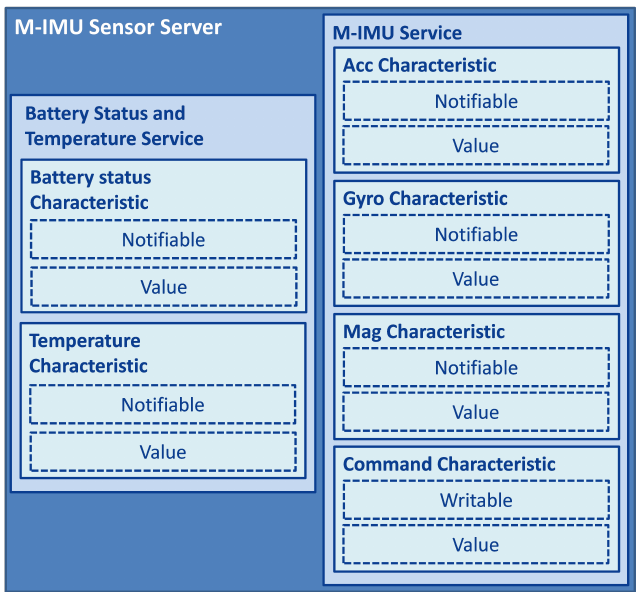
Figure 5. GATT data hierarchy, relative to the example described in Section